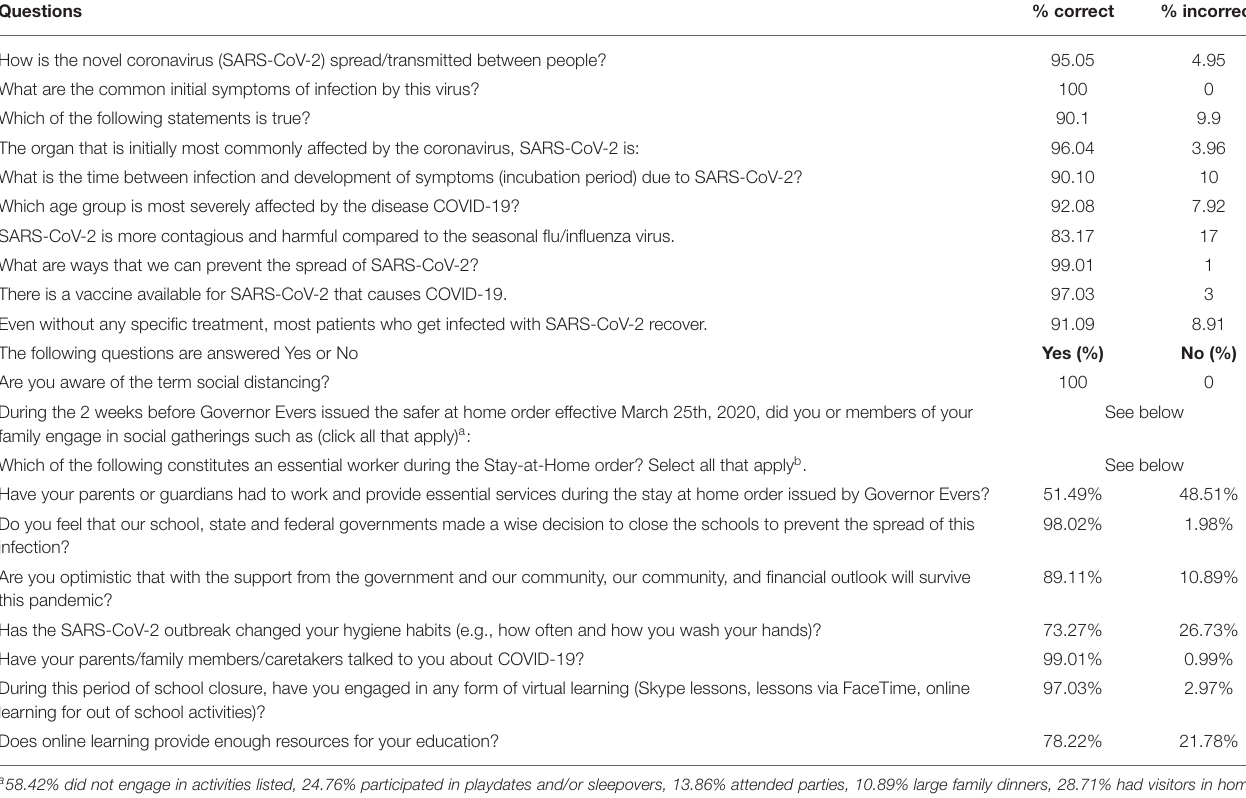
TABLE 1 | Pandemic knowledge survey responses of 8th–12th